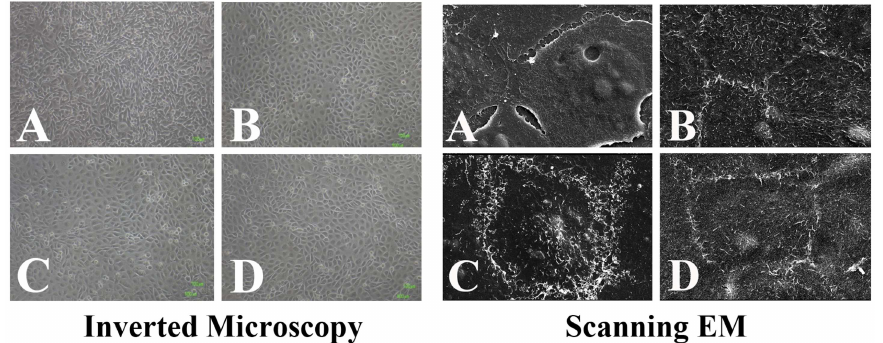
Fig 3. Cell differentiation: Inverted microscopy and scanning electron microscopy. Morphologiesof humancorneal epithelialcell (HCEC) lines cultivatedfor 48 hours with different blood derivatives, including(A) no serum, (B) human peripheral serum (HPS), (C) UltraGRO human platelet lysate (HPL), and (D) PLTMax HPL. Under invertedmicroscopy, cells incubatedwithout serum formed a coherent monolayerof irregularly shapedcells (A) while cells cultivatedin HPS, UltraGro, and PLTMax showedregular, polygonal flat cells (B-D). Under SEM, cells cultivatedwithout serum showedincreasedcell-to-cell junctionswithout the formation of microvillion the cell surface (A). The white arrow indicatedthe cell-to-celljunctionand the white arrow headsrepresentedthe microvilli on the cell surface. Exfoliationof the cells from the culture dish was suspected in cells cultivatedwithout blood derivatives. B-D) Cells cultivatedin HPS, UltraGro, and PLTMax demonstrated tight cell-to-celljunctionwith upright microvillihomogenously and densely distributed at the cellularsurface. Originalmagnifications of the inverted microscopy: 100X and SEM 1250X. UltraGRO: Human platelet lysate from Helios pharmaceutical. PLTMax: Human platelet lysate from Mill Creek